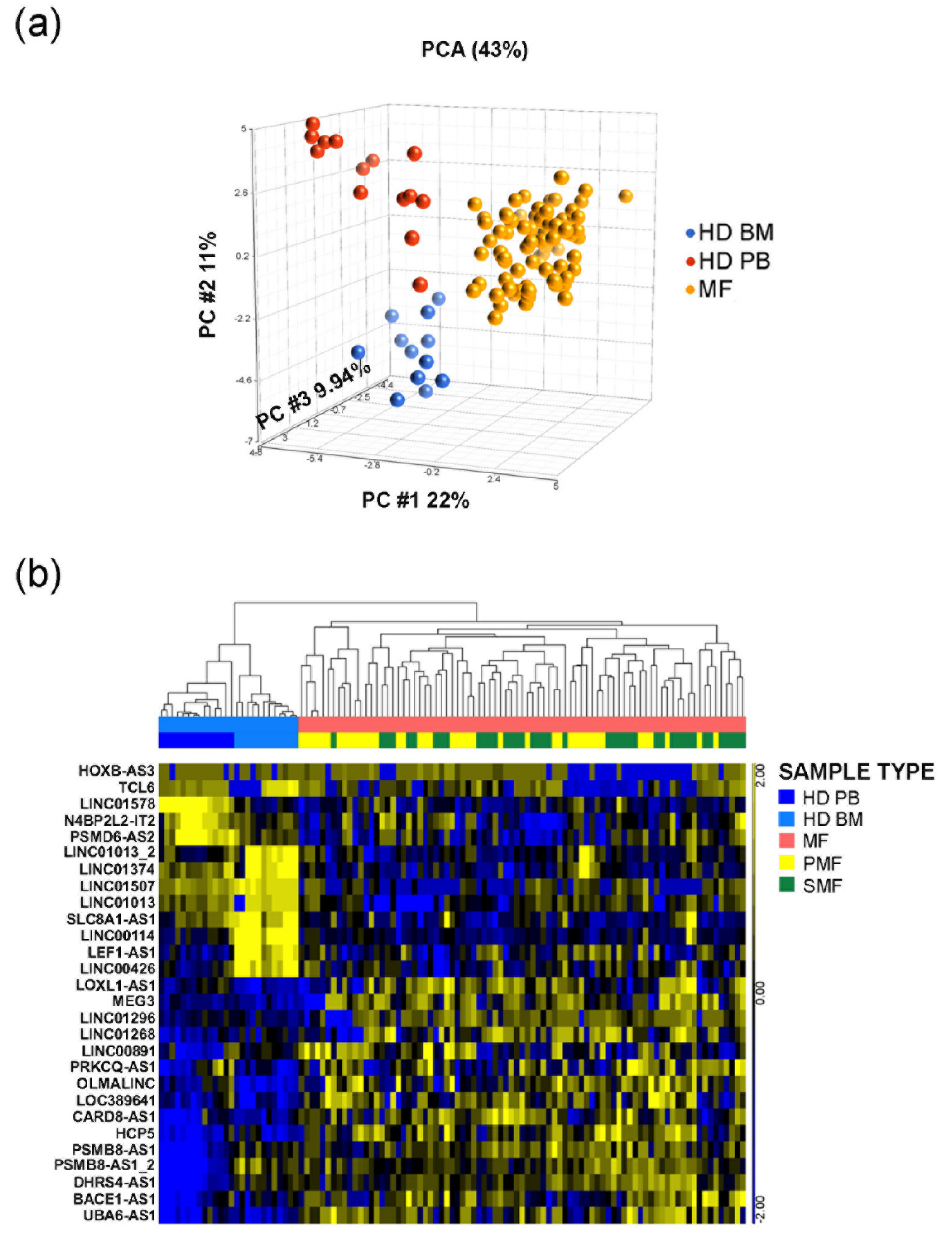
Figure 1. PCA and Hierarchical clustering of OpenArray Data. ( a ) PCA graph represents the global lncRNAs expression in CD34+ stem/progenitor cells. ( b ) Hierarchical clustering of samples according to the expression of 28 lncRNA transcripts, corresponding to 26 lncRNAs. Both analyses were performed by Partek GS, version 6.6. FDR = False Discovery Rate; BM = control samples isolated from bone marrow; PB = control samples isolated from peripheral blood; HD = healthy donor; MF = myelofibrosis patients; PMF = primary myelofibrosis; SMF = secondary myelofibrosis.